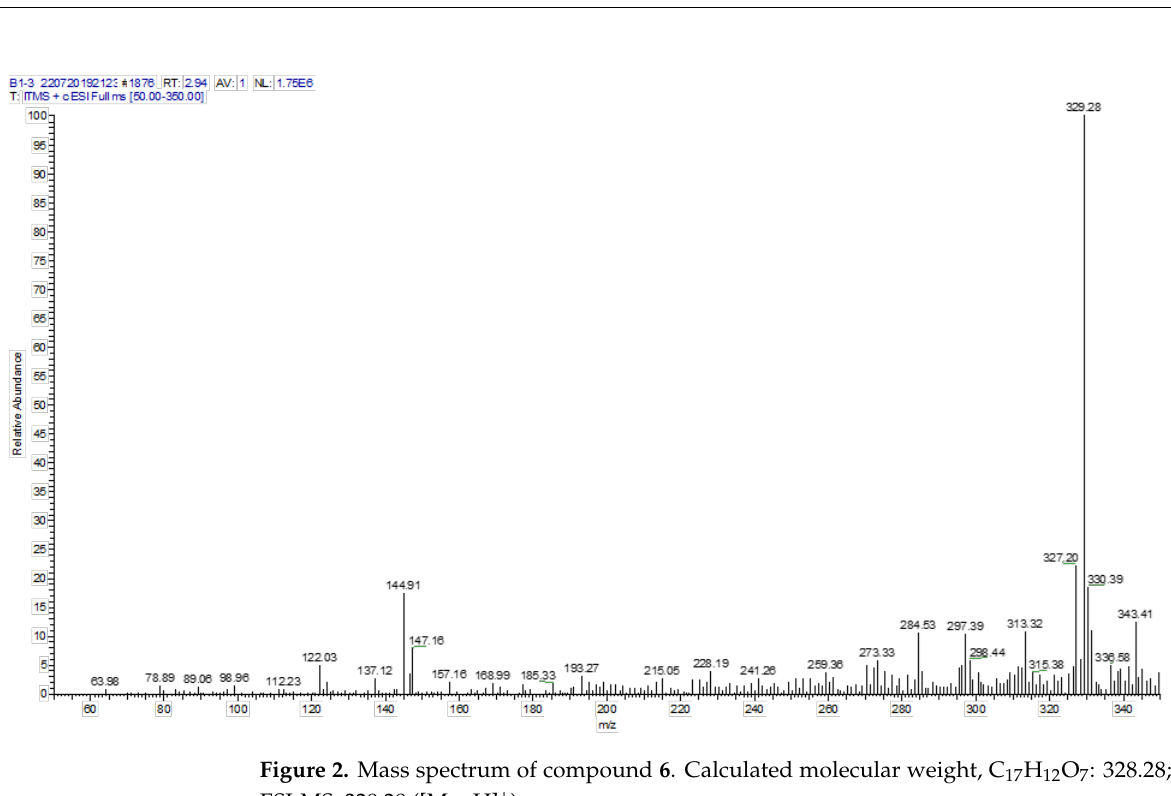
Figure 2. Mass spectrum of compound 6 . Calculated molecular weight, C 17 H 12 O 7 : 328.28; found: ESI-MS: 329.28 ([M + H] + ).